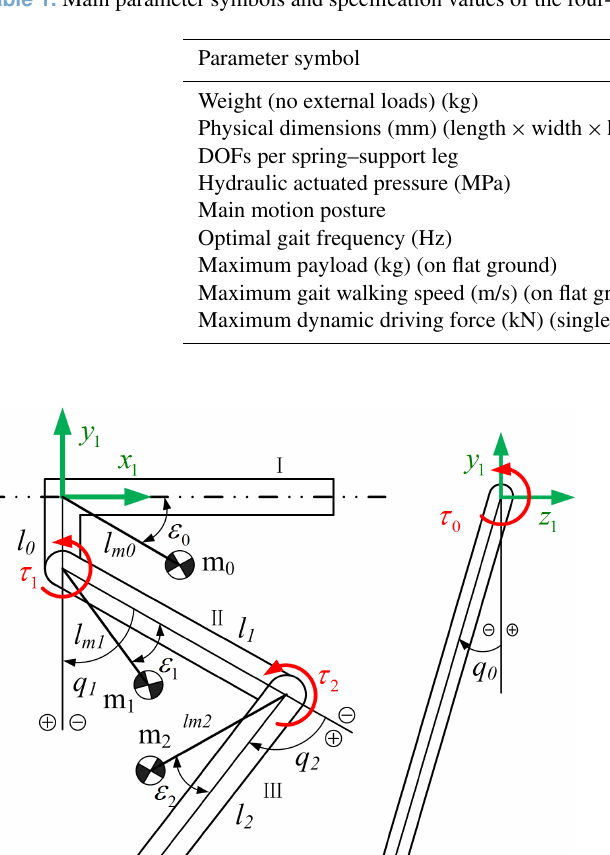
Table 1. Main parameter symbols and specification values of the four-legged robot.